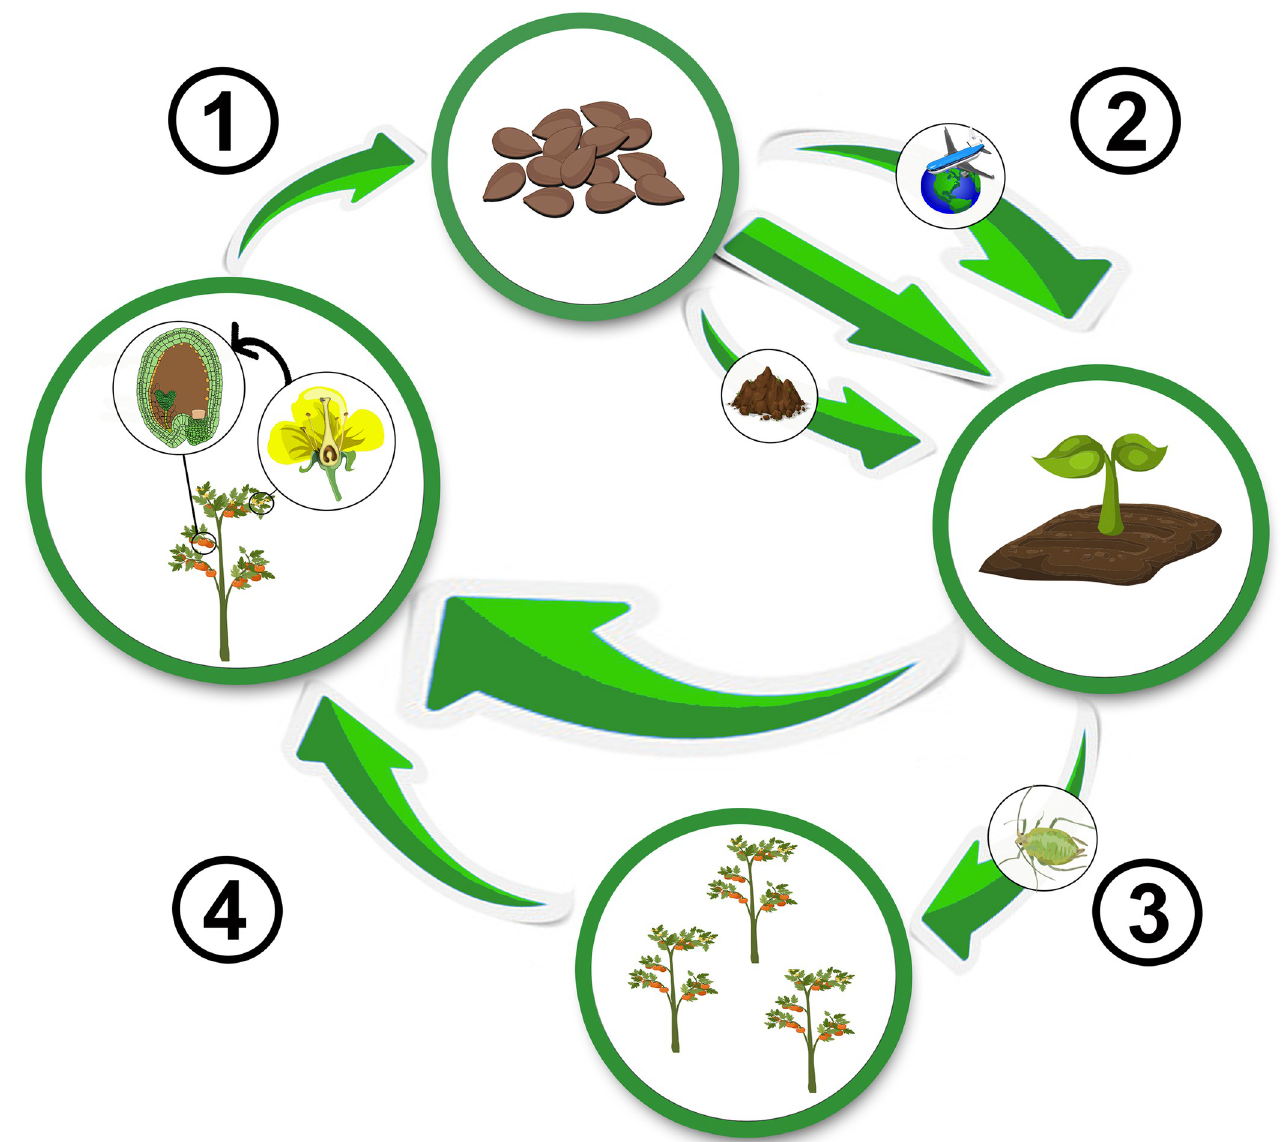
Fig 1. Virus seed transmission cycle. (1) Plant viruses reach seeds either by direct invasion of the embryo from the parental plant via the suspensor, and/or indirectly by infecting pollen grains or ovules, which lead to an infected embryo after fertilization. (2) Infected seeds may (i) directly germinate; (ii) remain for long periods of time in the soil; or (iii) be dispersed to long distances. In any of these 3 scenarios, infected seed will produce infected seedlings after germination. (3) Infected seedlings (and adult plants) from infected seeds will be sources of primary inoculum allowing virus dispersion through vectors. The picture represents aphids, which transmit 30% of plant viruses. (4) The cycle can be closed in 2 ways: (i) Viruses from infected seedlings/adult plants may again reach seeds leading to a second round of seed transmission, allowing virus persistence in the absence of vectors. (ii) Plants infected by vectors can produce infected seeds. Constructed using